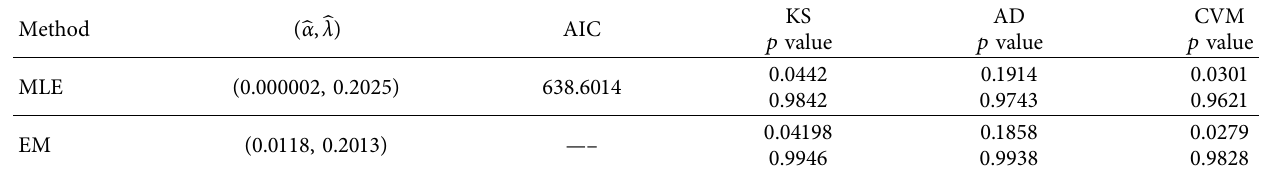
Table 4: Results of fitting quasi-Lindley model to dataset of Table